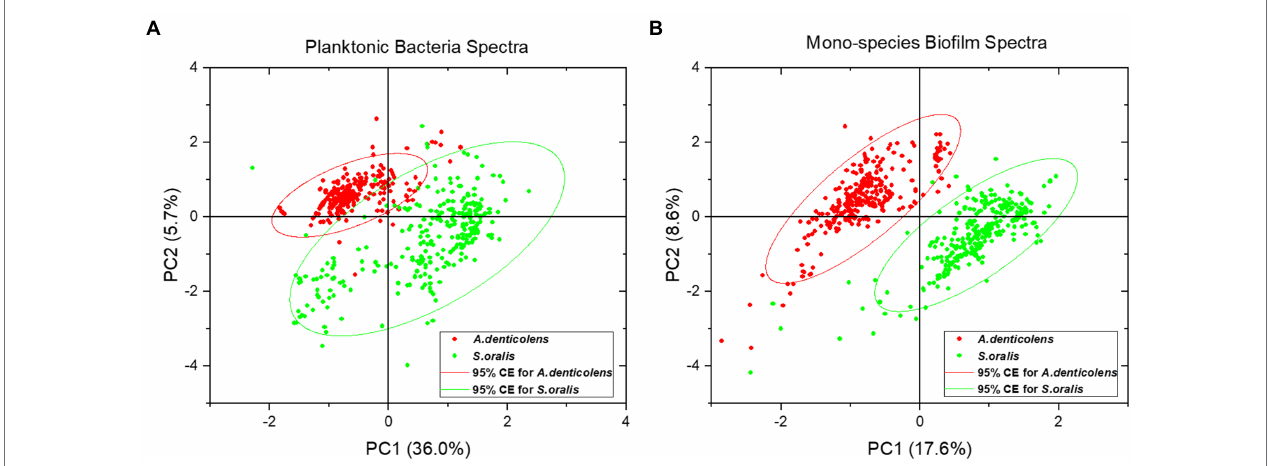
FIGURE 4 | Principle component analysis (PCA) of selected oral bacteria show the distribution of the second-order derivative of spectra (300 spectral samples for each strain) in a score plot. A. denticolens is marked in red, while S. oralis is marked in green. (A) Score plot for planktonic bacteria spectra with a 95% confidence ellipse. (B) Score plot for mono-species biofilm spectra with a 95% confidence